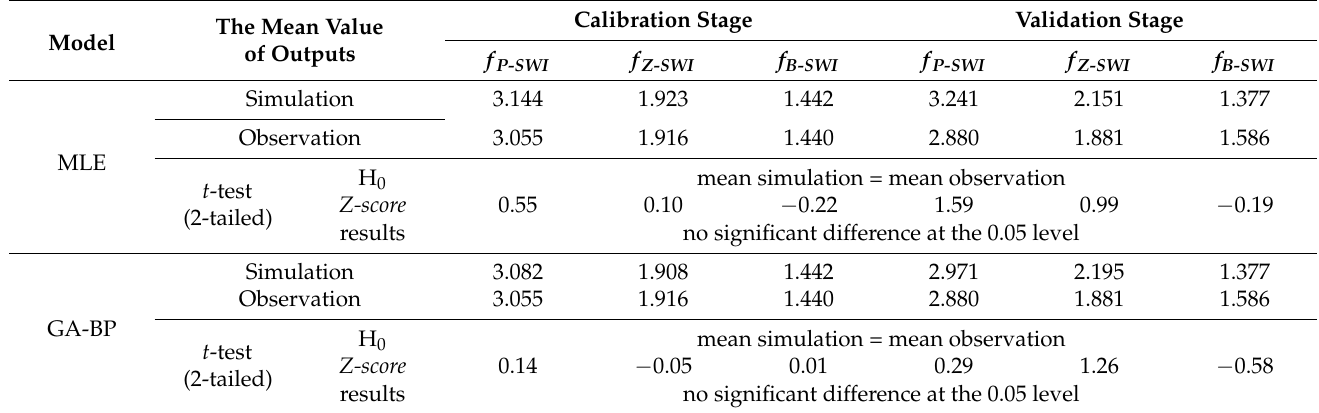
Table 5. The results of the t -test on the means of simulated and observed outputs.